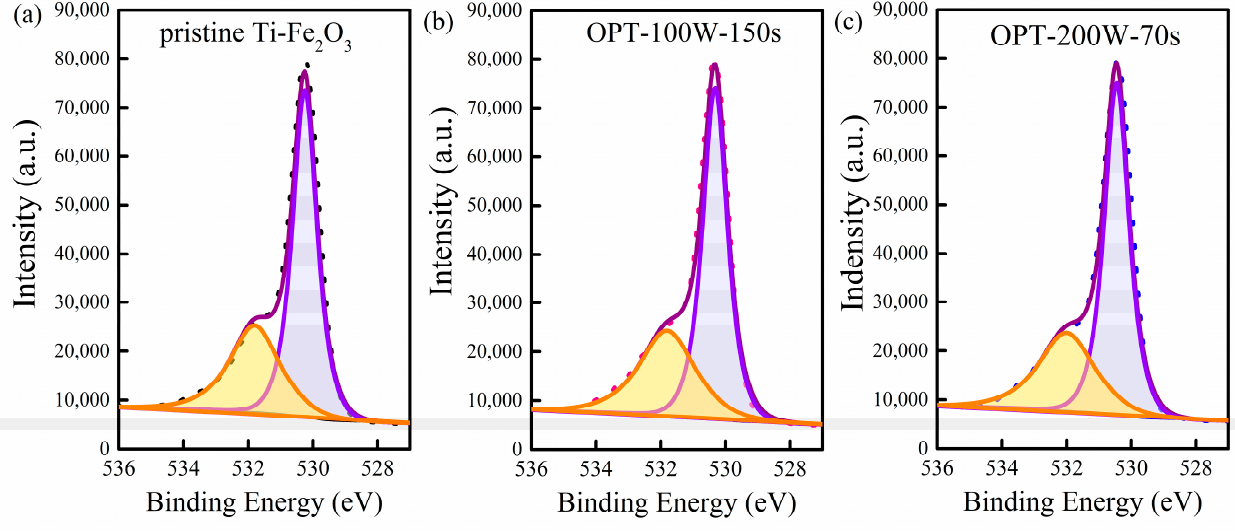
Figure 6. X-ray photoelectron spectroscopy of O 1s peaks of ( a ) pristine Ti-Fe 2 O 3 , ( b ) OPT-100W-150s, and ( c ) OPT-200W-70s samples. Table 3. The ratio of the integrated area of O v /O 2 − in the XPS spectra for the pristine Ti-Fe 2 O 3 , OPT- 100W-150s, and OPT-200W-70s samples.